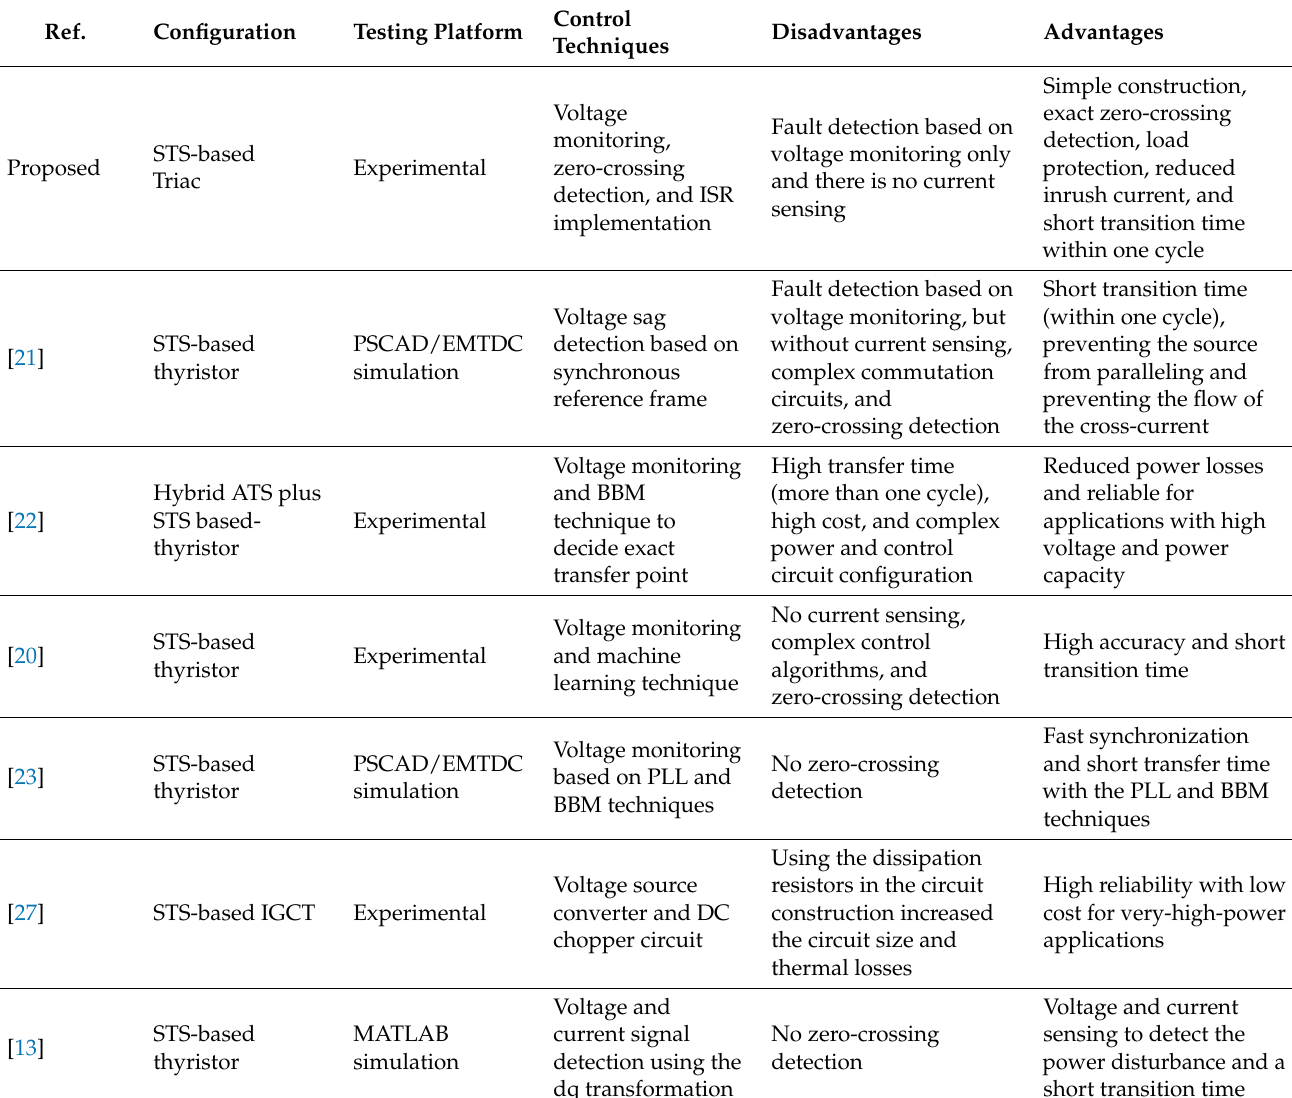
Table 3. Performance comparison of the proposed SSTS with previous